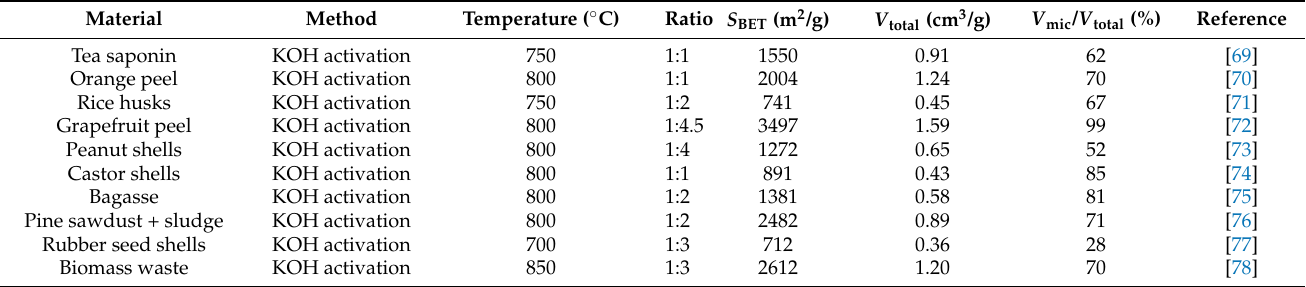
Table 1. Preparation of plant-derived carbon materials by KOH activation.